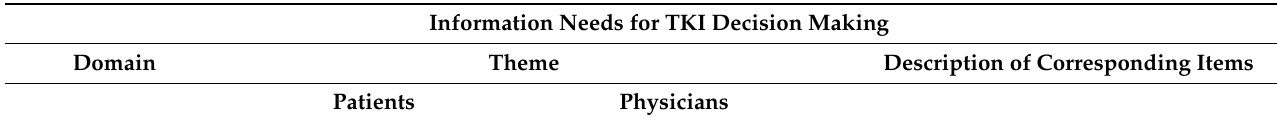
Table 4. Qualitative results for the advanced disease decision regarding “wait or start with TKIs”. Expressed information on the needs, preferences, and values of patients with and of physicians treating patients with